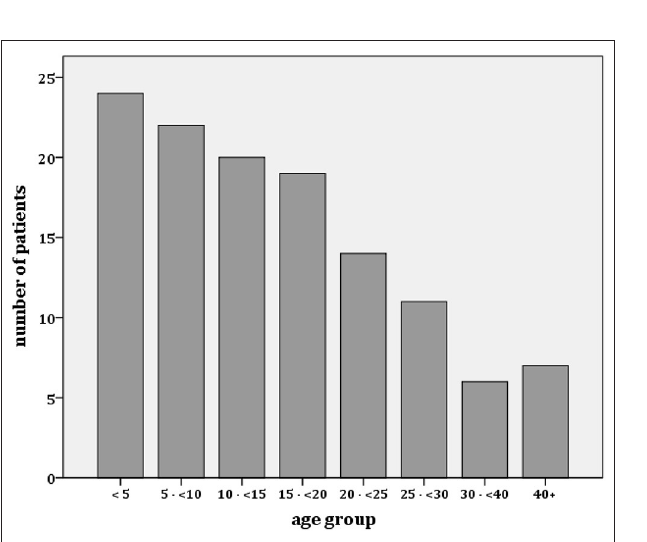
Complement C3c was decreased in 4/26 (15%) cases with PIGN with 0/43 with FSGS, MCNS, or MGN (n.s.). In addition, decreased C3c values were observed in two cases with MPGN and one with lupus nephritis.